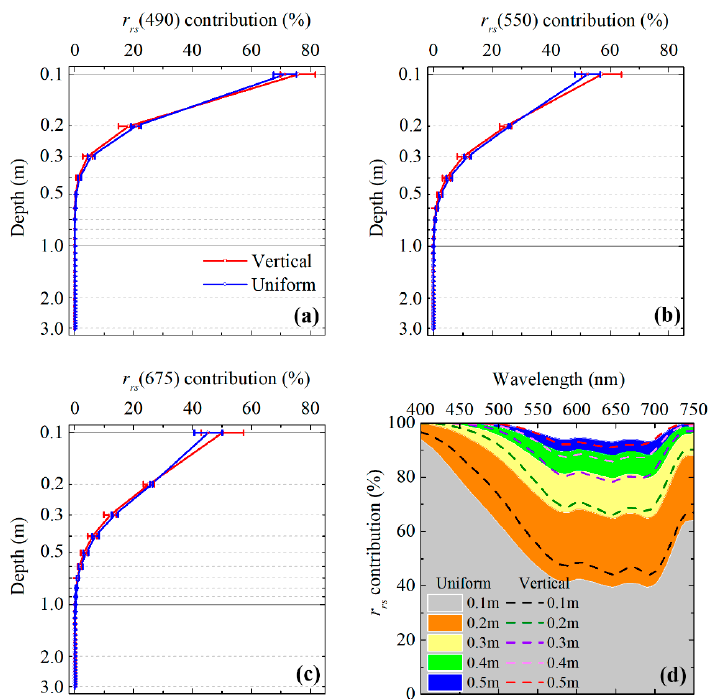
Figure 8. Average contribution of each layer to r rs of simulated data in vertical nonuniform (N = 1008) and uniform waters (N = 1008) at ( a ) 490, ( b ) 550, and ( c ) 675 nm. ( d ) Take L6 as an example, stacked r rs contribution of different layers in vertical nonuniform and uniform waters. The dashed lines represent the cases of vertical inhomogeneous water.